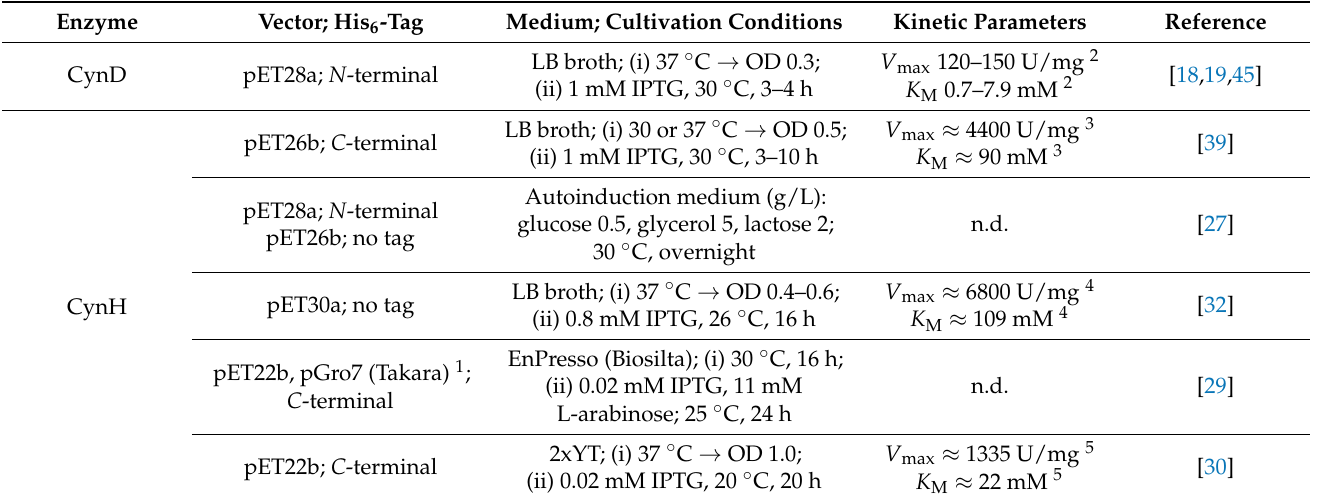
Table 3. Overexpression of the cynD and cynH genes in Escherichia coli.